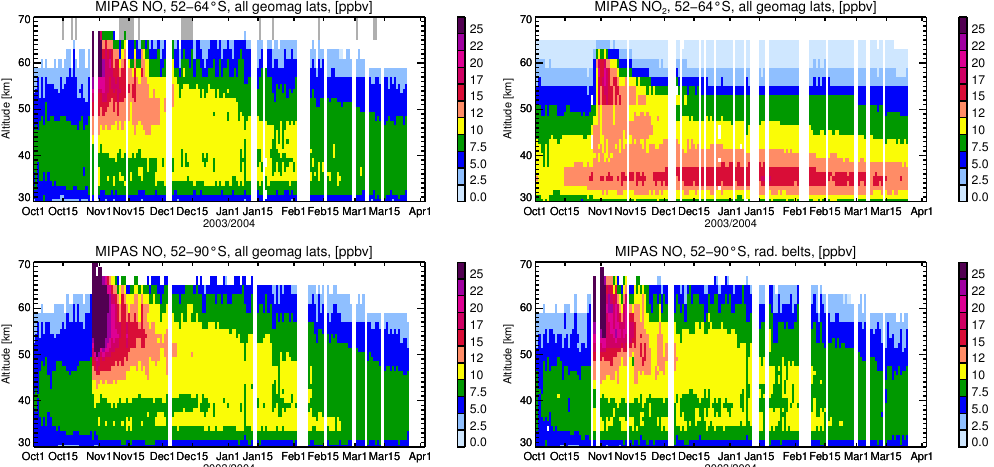
Figure 9. Temporal evolution of daytime NO (solar zenith angle, SZA, ≤ 88 ◦ ) and nighttime NO 2 (SZA ≥ 98 ◦ ) at high southern latitudes from 1 October 2003 to 30 March 2004. Top left: daily averages of NO from 52 to 64 ◦ S considering all geomagnetic latitudes. Marked in grey are days of enhanced electron fluxes, see also Fig. 1. Top right: NO 2 sampled over the same area. Lower panel: NO sampled over 52–90 ◦ S. Left: all geomagnetic latitudes, right: geomagnetic latitudes corresponding to the radiation belts. Only days with more than 15 data-points are considered for NO, only days with more than 10 data-points for NO 2 , and only data-points within ± 5median absolute deviations are considered for averaging.